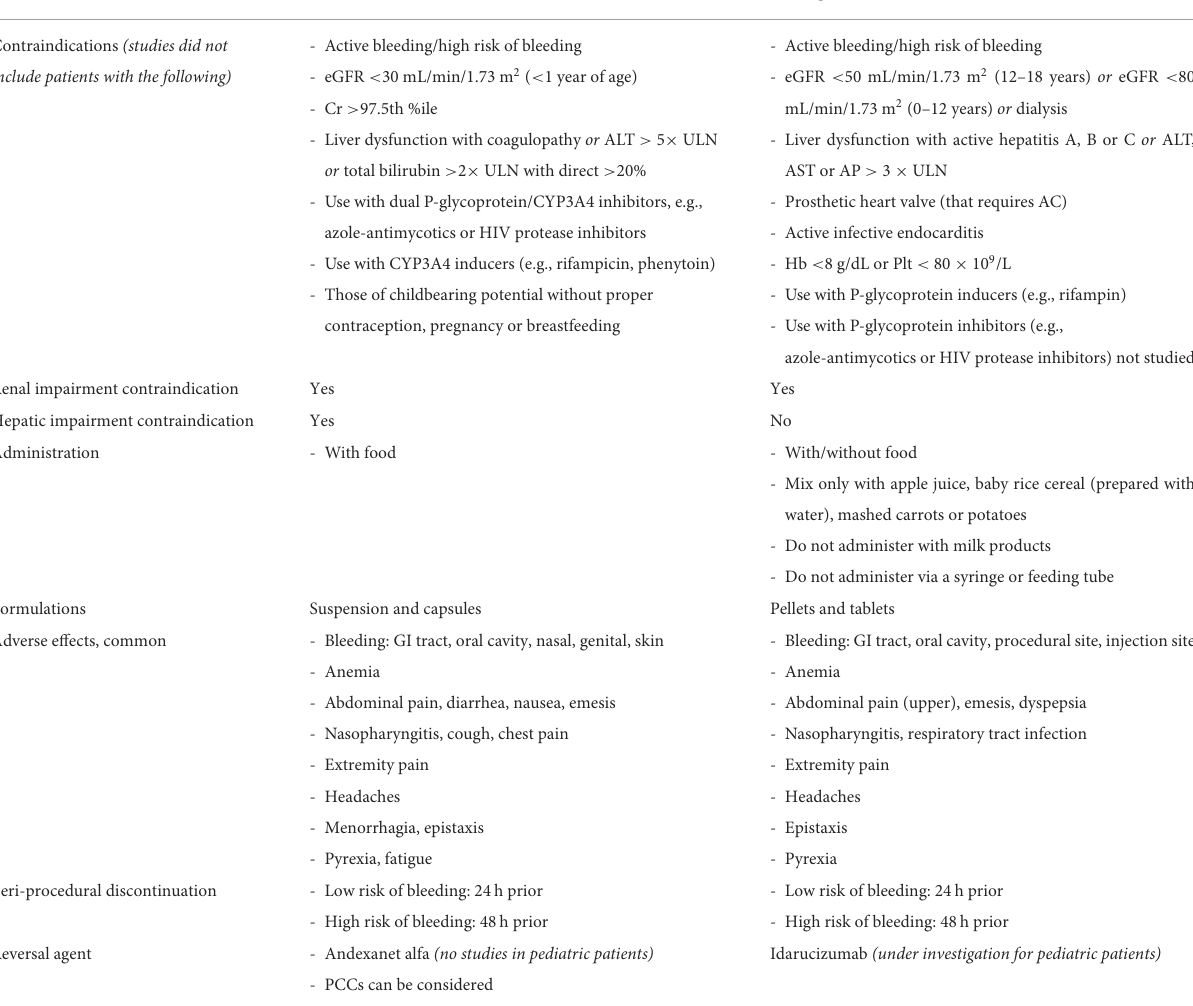
TABLE 2 DOAC contraindications, administration, and adverse effects. Rivaroxaban Dabigatran